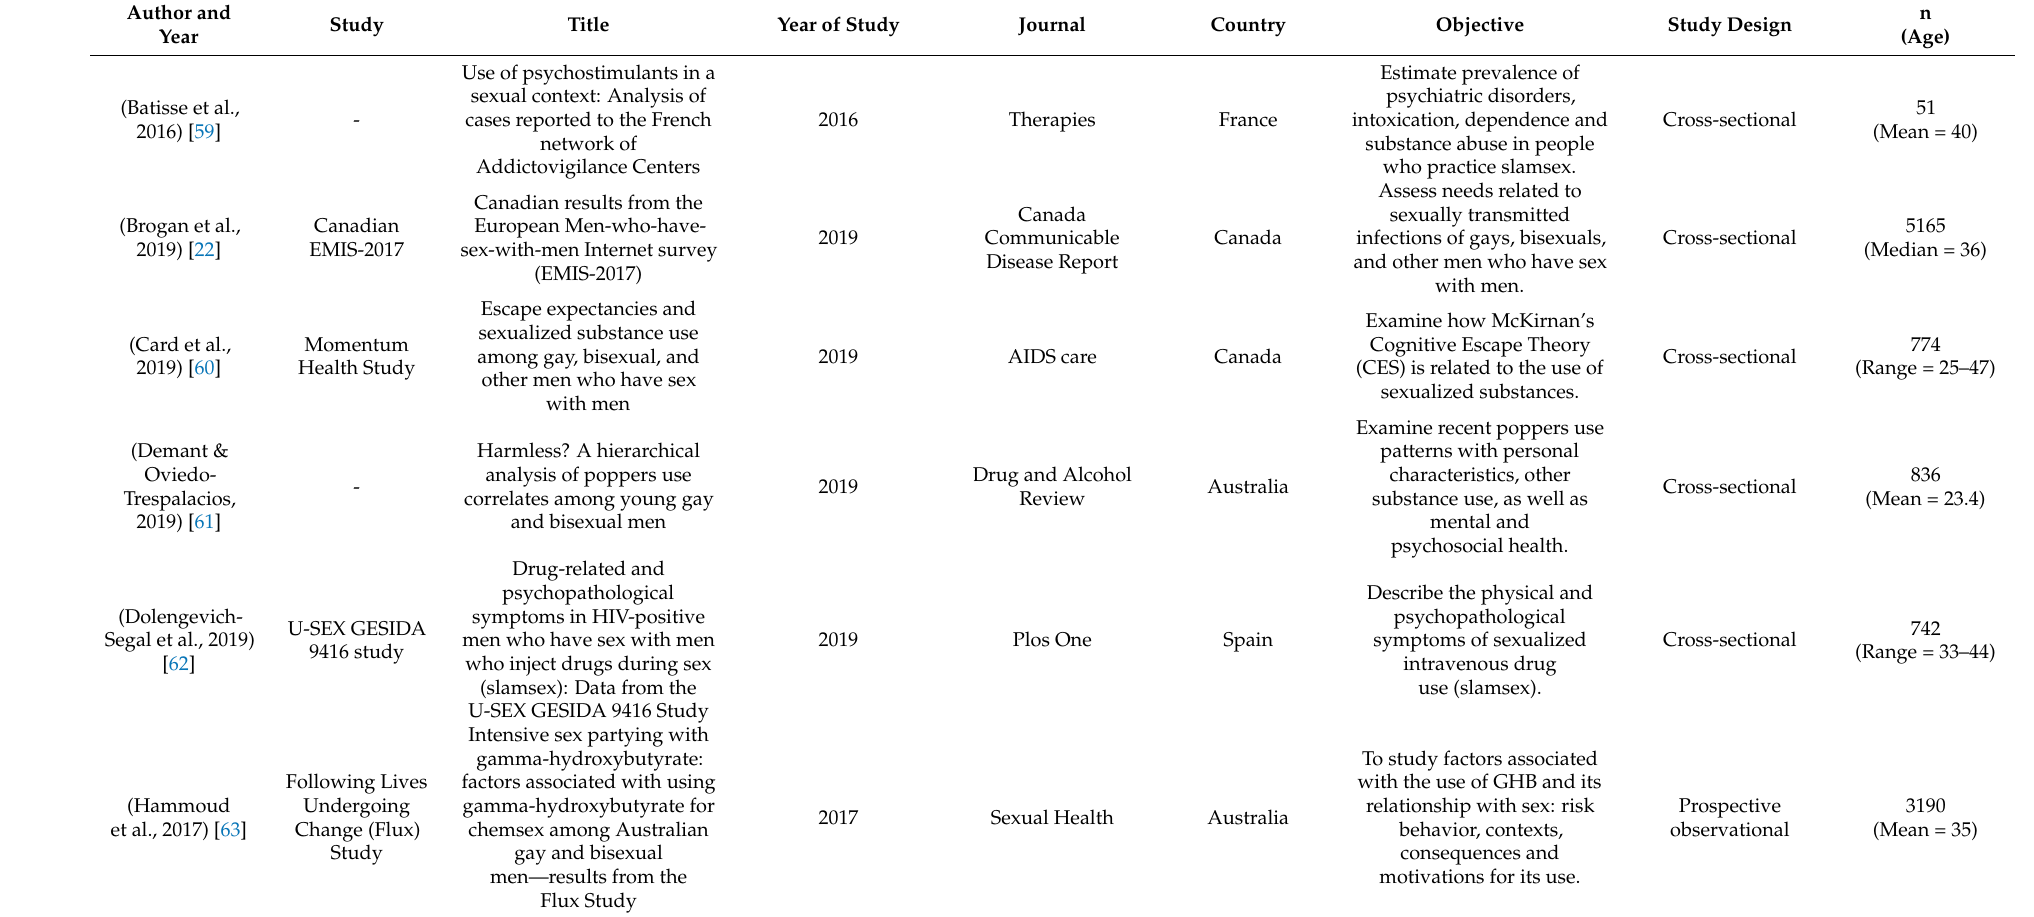
Table 2. Descriptive characteristics of the included